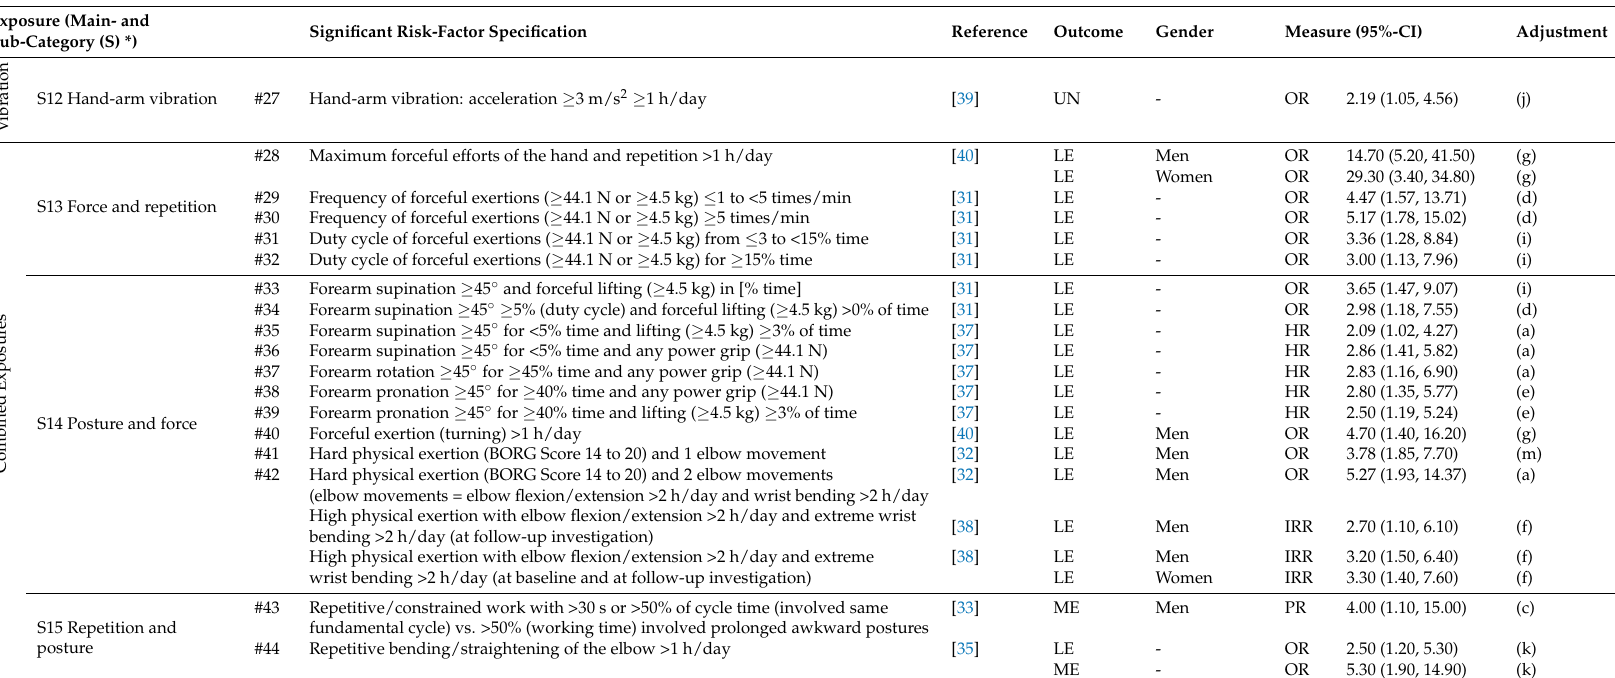
Legend: * Forceful exertions were only shown for power grip, details for pinch grip were shown in Supplementary File VII (Table S5); sub-categories of exposure S11 and S16 are not significant and are not presented here. Outcome: UN = ulnar neuropathy; LE = lateral epicondylitis; ME = medial epicondylitis; LE/ME = lateral and/or medial epicondylitis; Measure: odds ratio (OR); hazard ratio (HR); incidence rate ratio (IRR); prevalence ratio (PR); Adjustment: (a) = univariate analysis; (b) = multivariate analysis; adjustment not reported; (c) = adjustment not reported; (d) = final model (age, gender, body mass index (BMI), smoking status, personal, psychosocial, and work organizational variables); (e) = adjusted for age and gender; (f) = adjusted for age and combined physical work exposure including physical exertion and elbow movements; (g) = sex-adjusted; (h) = fully adjusted for body mass index, pack-years of smoking (continuous), alcohol consumption (continuous), side-specific fractures (never/ever), full anesthesia within a 5-year period up to the index year (no/yes), predisposing disorders (no/yes), use of crutches within a 5-year period up to the index year (no/yes), hand-arm intensive sports (0, 1, 2) and weight loss ≥ 10 kg within half a year during a 5-year period up to the index year (no/yes) and all occupational exposure variables in Table 2 of [39]; (i) = adjusted for age (continuous), gender, BMI (continuous); (j) = partly adjusted for body mass index, pack-years of smoking (continuous), alcohol consumption (continuous), side-specific fractures (never/ever), full anesthesia within a 5-year period up to the index year (no/yes), predisposing disorders (no/yes), use of crutches within a 5-year period up to the index year (no/yes), hand–arm intensive sports (0, 1, 2) and weight loss ≥ 10 kg within half a year during a 5-year period up to the index year (no/yes); (k) = multivariate analyses; adjusted for vitality, white/blue collar, age in four age bands and sex; (m) = adjusted for individual characteristics, repetition, combined physical work exposure including physical exertion, elbow flexion/extension and wrist bending, and social support with aggregation of low categories for combined physical work exposure; (n) = adjusted for age and